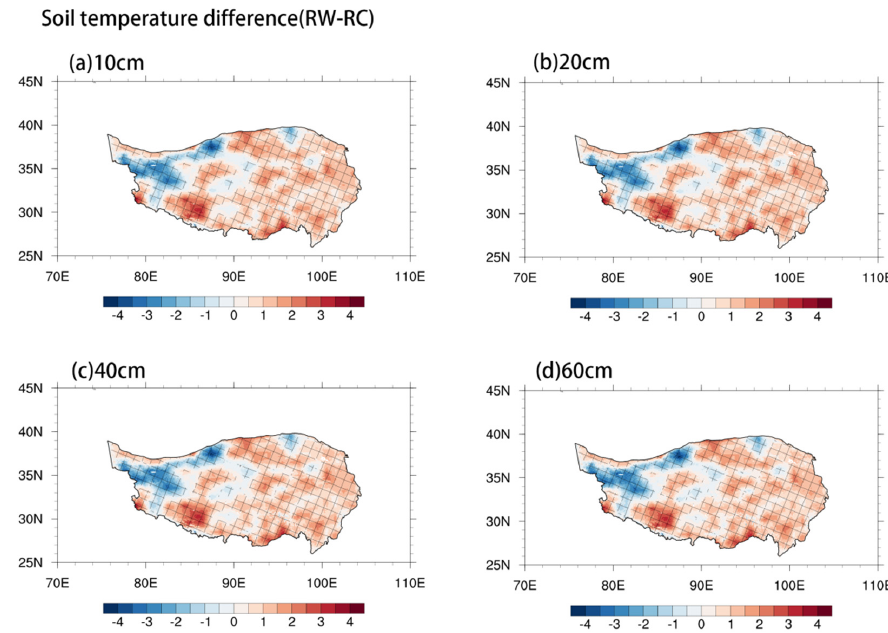
Figure 7. Same as Figure 5, but for differences in average soil temperature between RW and RC.